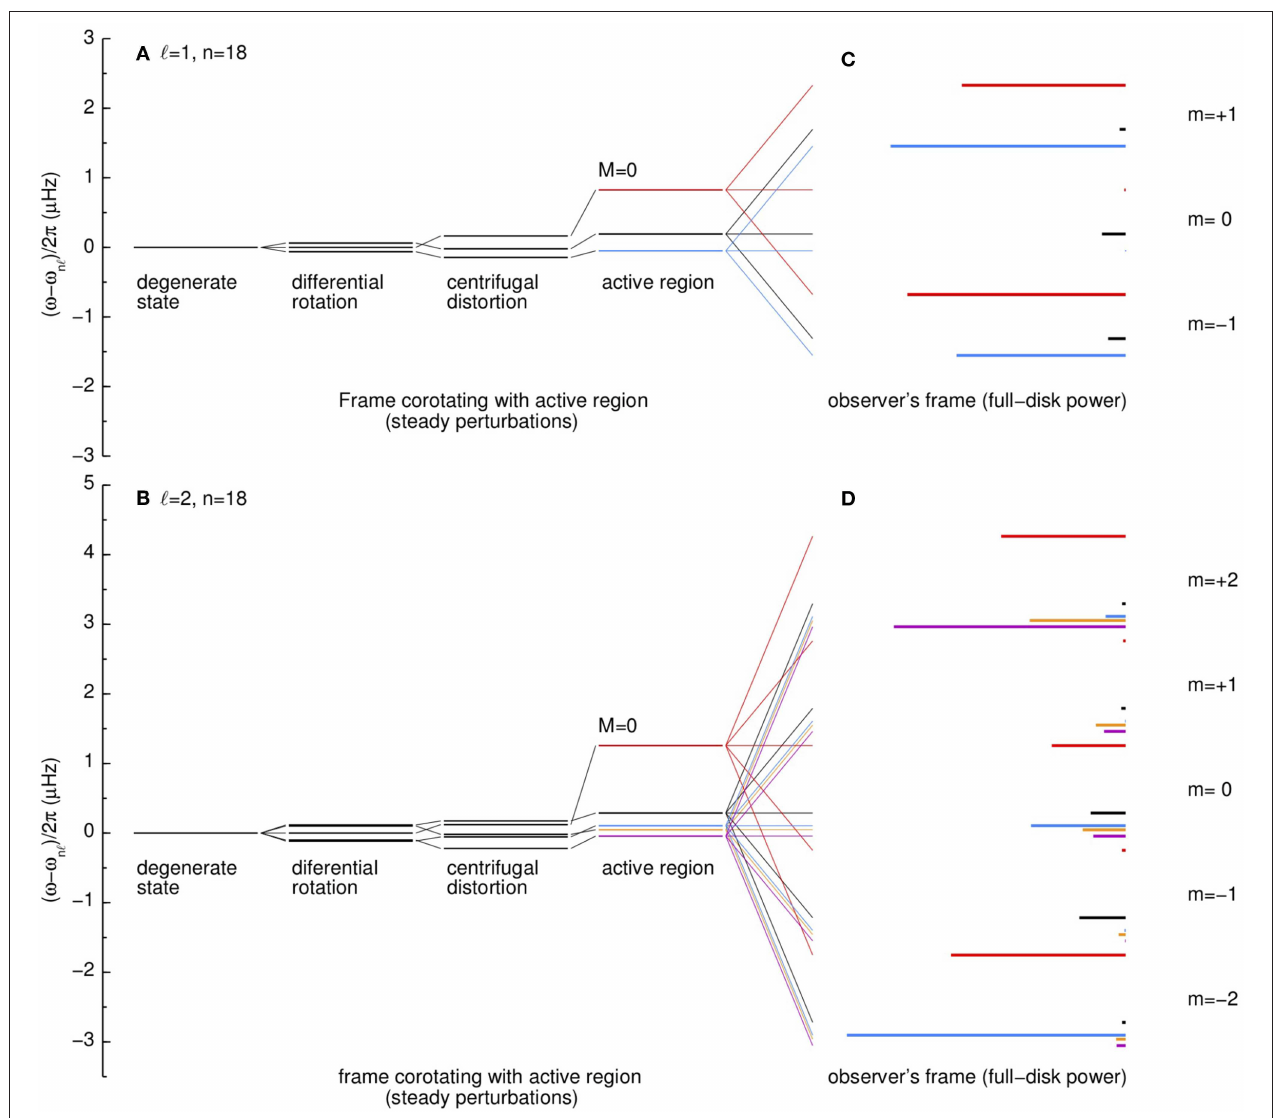
FIGURE 3 | Perturbations to the mode eigenfrequencies in the frame that is corotating with the active region, for the multiplets with ( ℓ , n ) = (1,18) (A) and with ( ℓ , n ) = (2,18) (B) . The star is Sun-like and rotates with a scaled solar differential rotation profile (rotation period is approximately 8 days). The active region perturbation is specified by ε n ℓ = 0.003, α = 23 ◦ , and β = 80 ◦ . The rotational frequency of the active region at colatitude β is (cid:127) β / 2 π is 1.504 µ Hz. The frequency of the mode M = 0 is the most shifted. (C,D) The (2 ℓ + 1) 2 peaks of the power spectrum as seen in the observer’s frame, for an inclination angle i = 80 ◦ . For each m , the M -components are identified with different colors: red for M = 0, black for M = 1, blue for M = − 1, orange for M = 2, and pink for M = − 2. The peaks with the same colors are statistically correlated to each other (according to Equation 66).